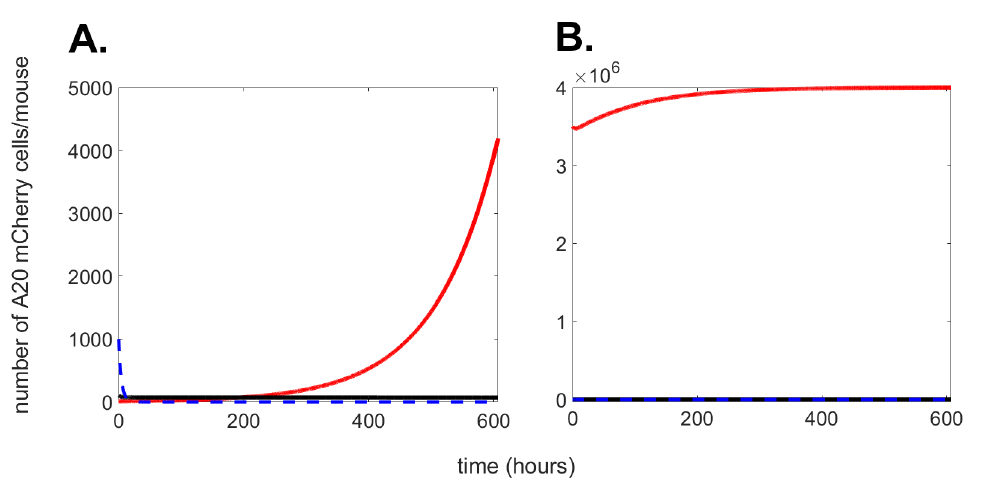
Figure A1. Numerical simulation of Equations (A1)–(A3) with parameters as in Table 1. The graph shows the progression over time (up to 600 h) of cancer cells ( red solid line); effector cells ( black solid line), and drug ( blue dashed line). In ( A ), initial conditions: A ( 0 ) = 10; E ( 0 ) = 100; C ( 0 ) = 1000. In ( B ), initial conditions: A ( 0 ) = 3.5 × 10 6 ; E ( 0 ) = 100; C ( 0 ) =